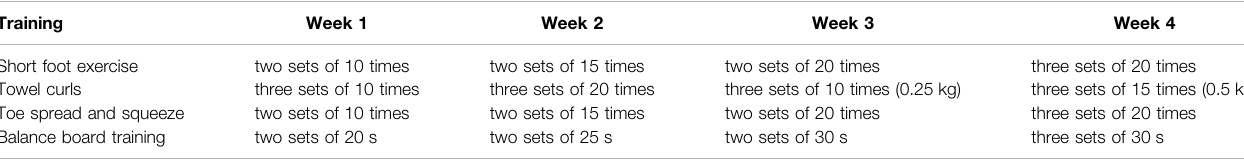
TABLE 2 | Foot core exercise